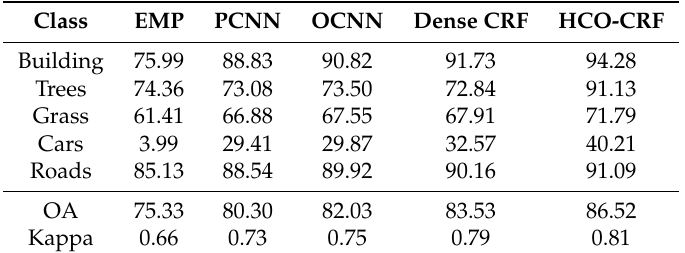
Table 6. Classification results of Vaihingen dataset with different strategies (in percentage). OA: Overall